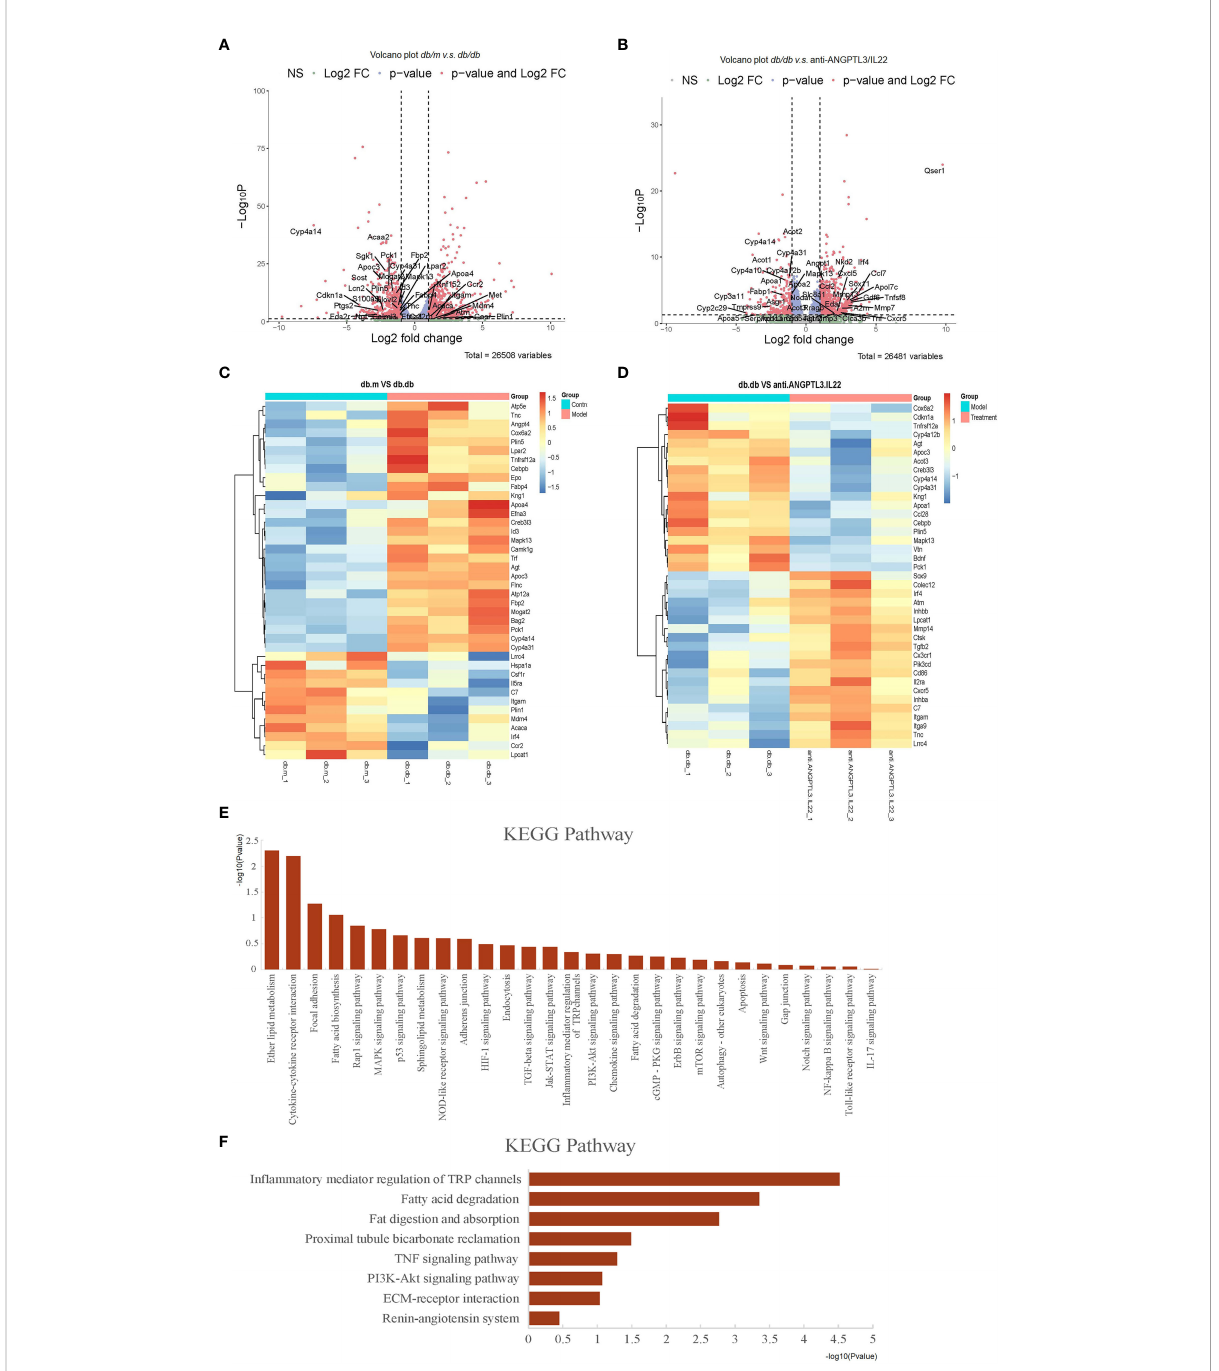
FIGURE 7 Transcriptomic analysis of db/db mice treated with anti-ANGPTL3/IL22. (A) Differential expression of genes related to in fl ammation, podocyte injury and metabolism in db/m mice compared to db/db mice were shown in volcano plots (log2 fold change ≥ 1 or ≤ -1 in the horizontal coordinate and p value ≤ 0.05 in the vertical coordinate). (B) Differential expression of genes related to in fl ammation, podocyte injury and metabolism (log2 fold change ≥ 1 or ≤ -1 in the horizontal coordinate and p value ≤ 0.05 in the vertical coordinate) in db/db compared to anti- ANGPTL3/IL22 treatment mice. (C) Cluster analysis of differentially expressed genes including in fl ammation-related, metabolism-related and podocyte damage process-related genes between db/m and db/db mice. (D) Cluster analysis of differentially expressed genes including in fl ammation-related, metabolism-related and podocyte damage process-related genes between anti-ANGPTL3/IL22 treated mice and db/db mice. (E) KEGG analysis of genes signi fi cantly up-regulated in db/db mice. (F) KEGG analysis of genes obviously down-regulated in anti- ANGPTL3/IL22 administration